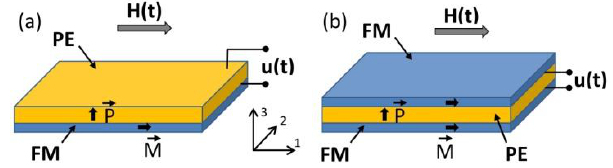
Figure 1. Geometry of bilayer ( a ) and trilayer ( b ) structures.